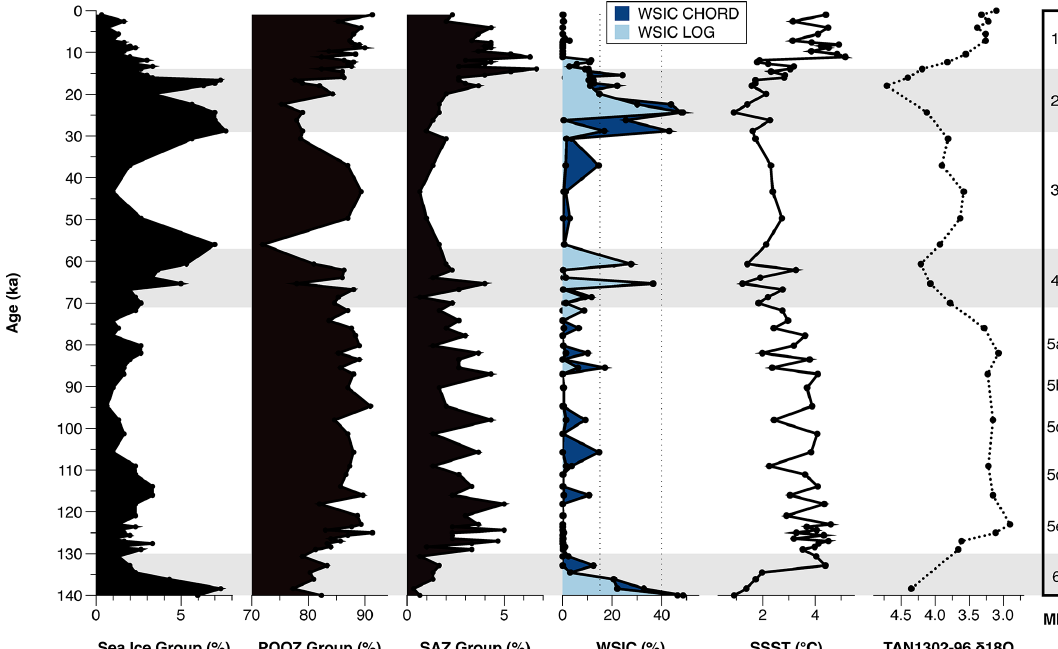
Figure 4. Diatom assemblages results from TAN1302-96 separated into percentage contribution from each taxonomic group (sea ice group, POOZ, and SAZ; see Table 1) over a full glacial–interglacial cycle. Using the modern analog technique (MAT), winter sea ice concentration (WSIC) and summer sea surface temperature (SSST) were estimated and compared against the δ 18 O signature of